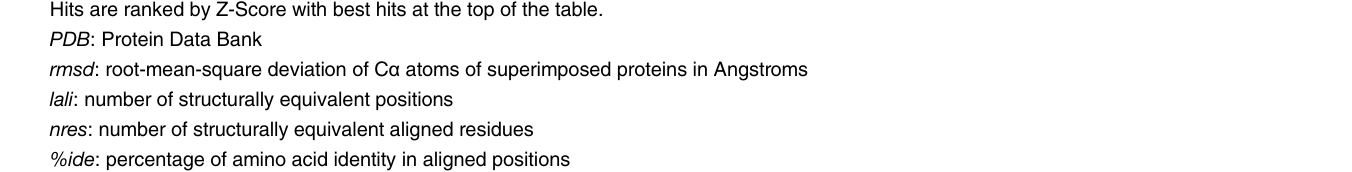
Cell wall surface anchor family protein